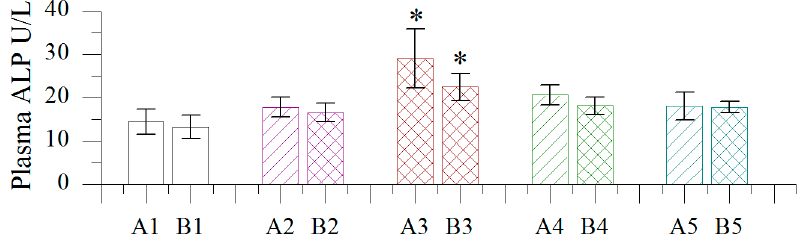
Figure 3. Effect of different concentrations of volatile oil from Blumea balsamifera (BB oil) on plasma ALP levels in rats. 1–5: CK, Olive oil, 100% BB oil, 50% BB oil, 20% BB oil; A, B: normal skin, wound skin; *: Columns labeled by * are significantly different from others by Duncan’s test at p < 0.05.